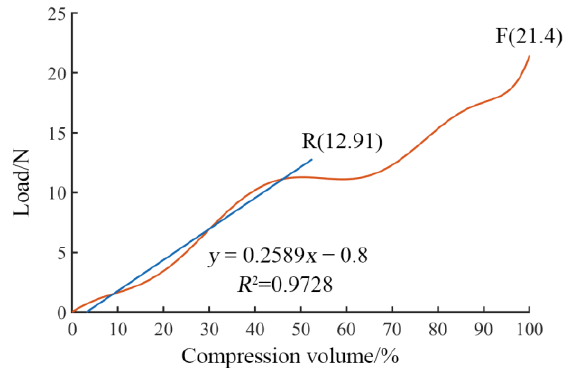
Figure 1. Radial load versus compression on the stem of pepper cavity tray seedlings.